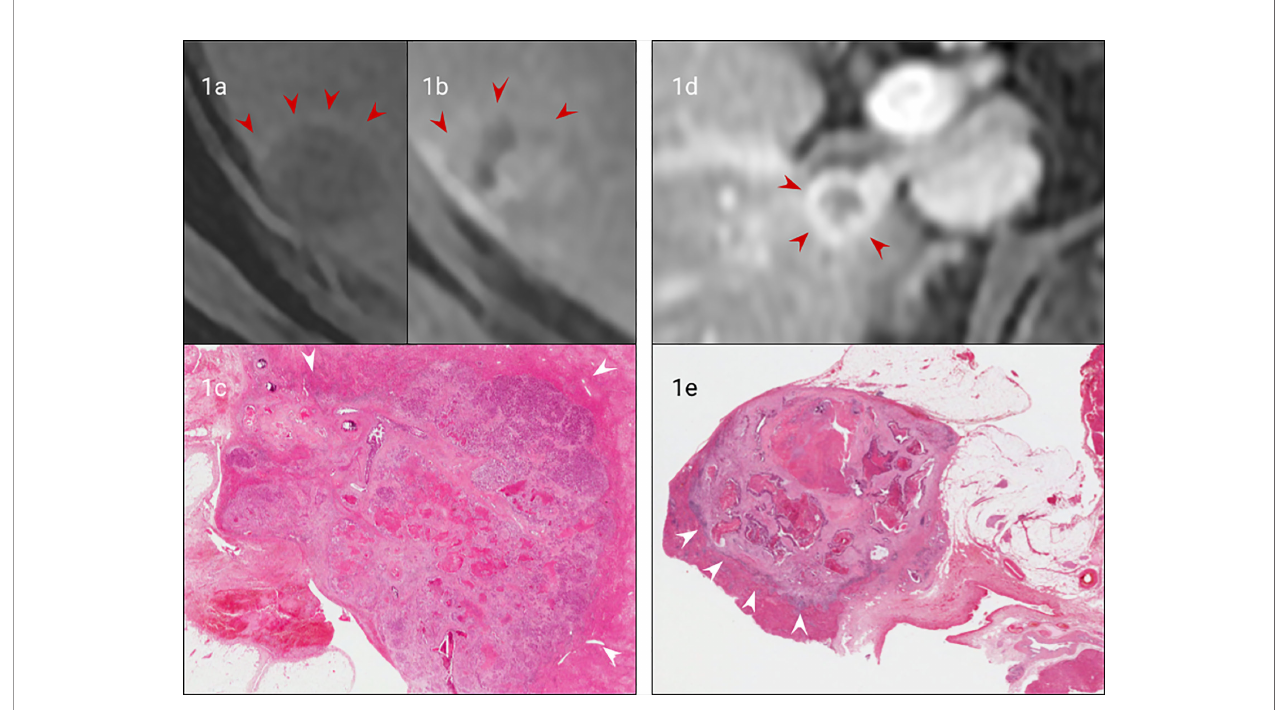
FIGURE 1 | Matched imaging and histology of non-encapsulated (A – C) vs capsulated CRLM (A, D, E) . Arterial phase gadolinium-enhanced T1 fat saturated MRI of a CRLM with early peripheral enhancement indicating compression of hepatocytes (arrows), (B) . Portal venous gadolinium-enhanced T1 fat saturated MRI showing an absence of peripheral enhancement with isointensity to normal liver (arrows), (C) . H&E staining (from (A, B) con fi rming no true capsule with peripheral compression of hepatocytes (arrows). (D) . Portal venous phase gadolinium-enhanced T1 fat saturated MRI demonstrating clear peripheral enhancement of a fi brotic capsule (arrows), (E) . H&E staining of the CRLM (from (D) con fi rming a true fi brotic capsule/desmoplastic interface